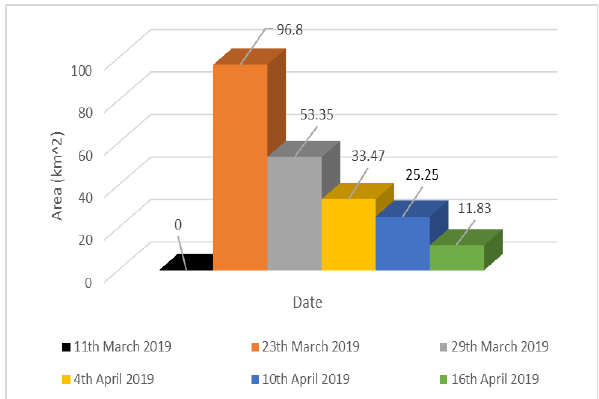
Figure 7. Chart of flood areas changing in Aq’qala